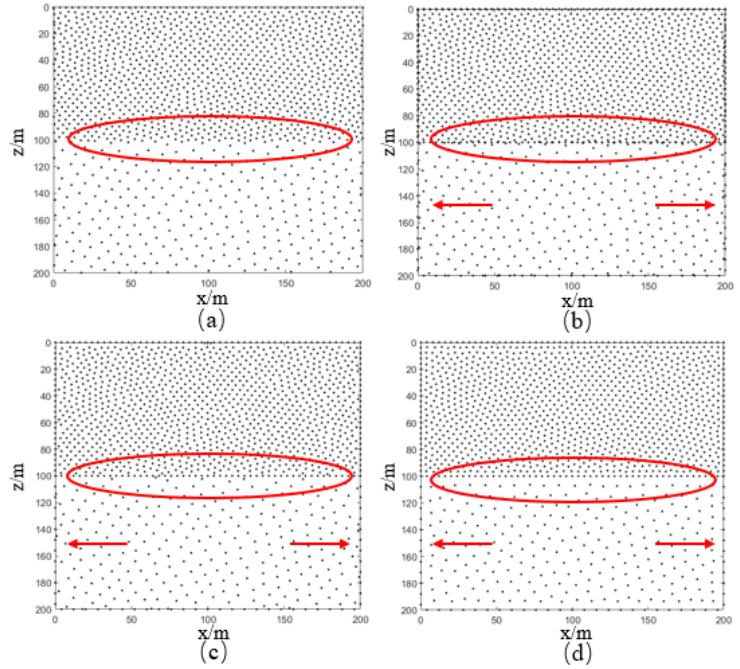
Figure 4. Node generation of two ‐ layer model: ( a ) Variable density nodes; ( b ) Variable density nodes overlap with boundary nodes and interface nodes; ( c ) Delete the nodes in ( b ) that are too close to the interface or boundary; ( d ) Nodes after adjustment based on Voronoi centroid algorithm.